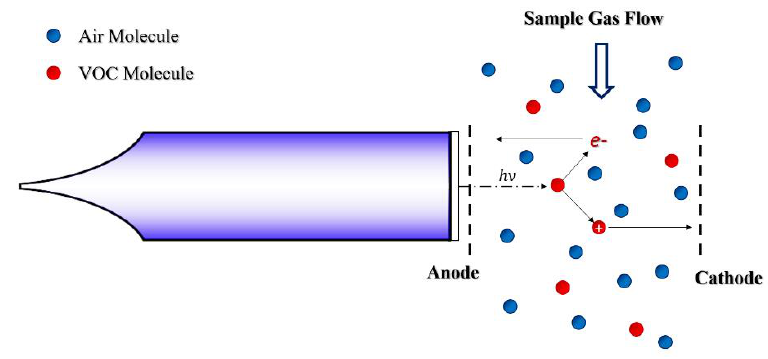
Figure 5. General schematic of a photo-ionization detection (PID) sensor.